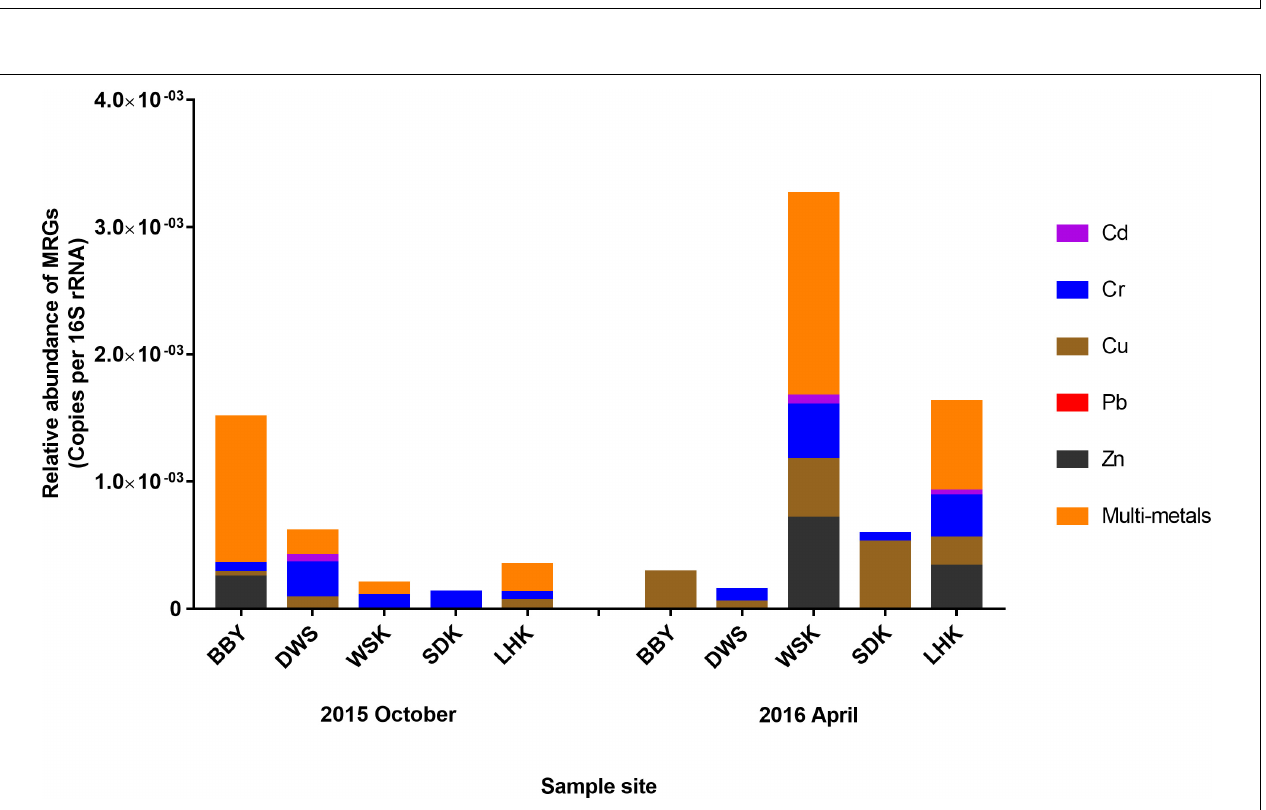
FIGURE 9 | Relative abundance of metal resistance genes (MRGs) in bacterial community at various sites of the Yangtze River estuary sampled during October 2015 and April 2016. WSK, SDK, and LHK were estuarine mudflats; BBY and DWS were salt marshes.